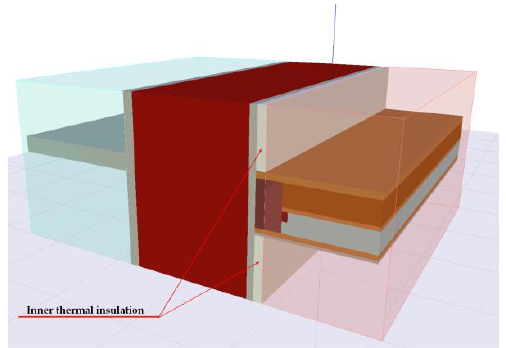
Figure 19. Geometric model—solid view from inside the room. Inner thermal insulation is marked with arrows.